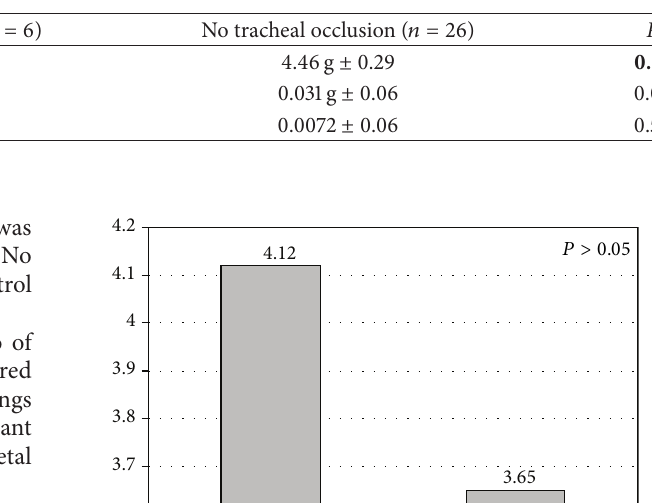
Table 3: Fetal weight, lung weight, and lung-to-fetal ratio of fetuses with CDH divided into two groups—tracheal occlusion and no tracheal occlusion.